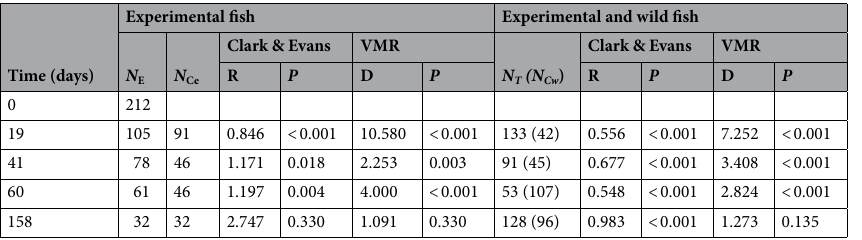
Table 1. Clark–Evans index of aggregation and variance-to-mean ratio (VMR index) for the four sampling events (19, 41, 60, and 158 days after release). Analyses were conducted twice, for samples including or excluding the spatial positions occupied by wild fish. N E , minimum number of experimental fish in the study section at each sampling session (regardless of whether they were captured or non-captured); N Ce , N T , captures of experimental fish and total capture, respectively (number of wild fish ( N Cw ) in parentheses).